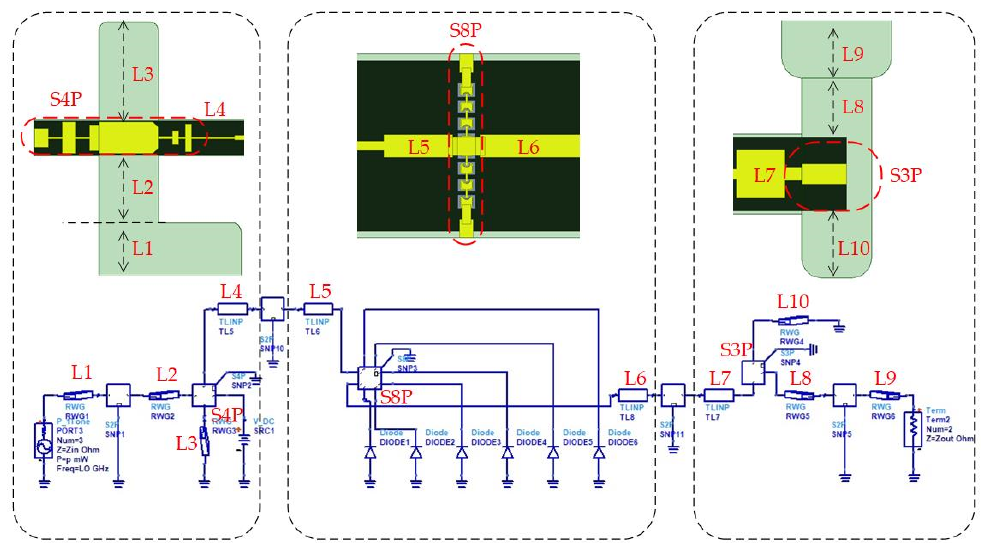
Figure 5. Design of the 215 GHz monolithic integrated tripler based on the field-circuit method (L1 = 0.5 mm, L2 = 0.725 mm, L3 = 1.06 mm, L4 = 0.47 mm, L5 = 0.15 mm, L6 = 0.33 mm, L7 = 0.24 mm, L8 = 0.28 mm, L9 = 0.2 mm, and L10 = 0.32 mm).